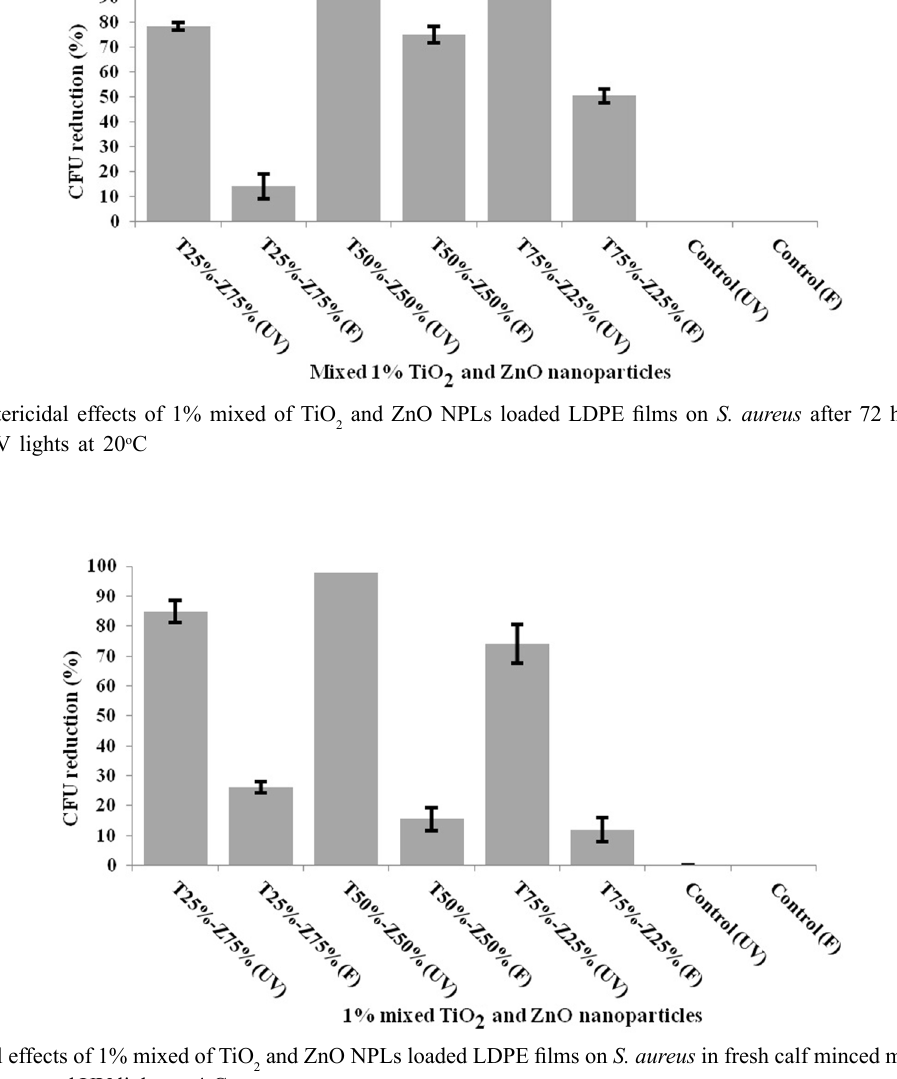
and ZnO NPLs loaded LDPE films on S. aureus in fresh calf minced meat after 72 hr in the 2